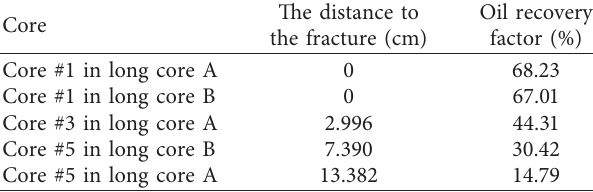
Table 3: The distance from the core center to the fracture.